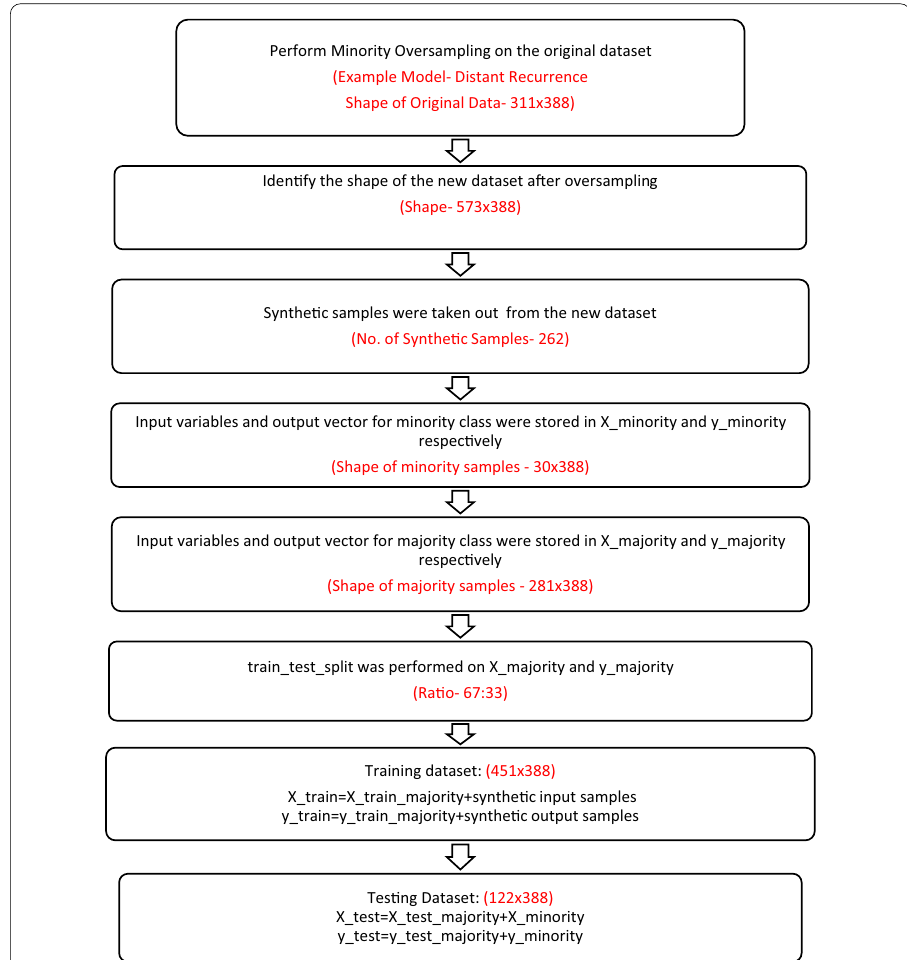
Fig. 2 Flow Diagram for minority oversampling using an example of distant